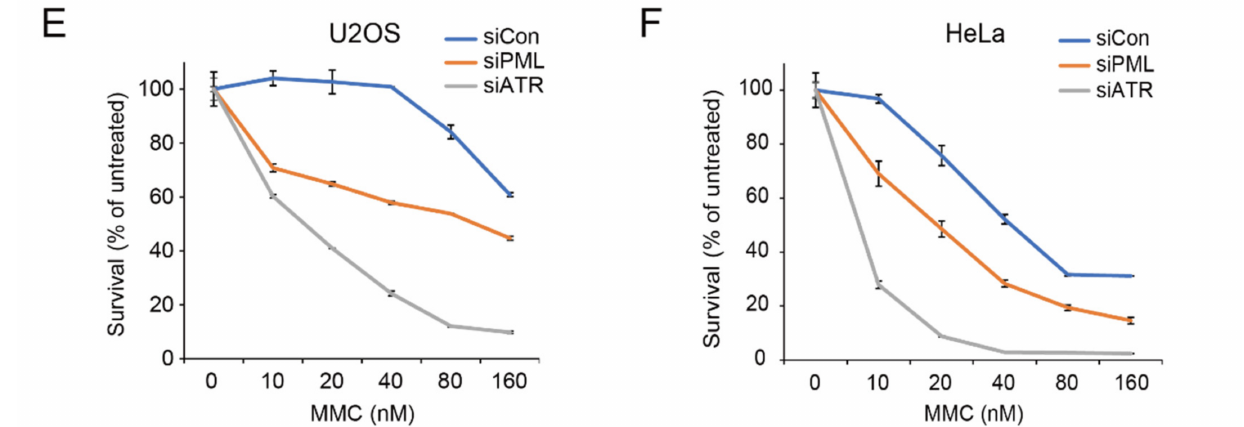
Figure 1. PML is required for FANCD2 mono-ubiquitination and foci formation in response to genotoxic agents inducing interstrand DNA crosslinks. ( A , C ) U2OS and HeLa cells were transfected with siControl, si PML , or siATR and treated with 1 µ M mitomycin C (MMC) for 24 h. FANCD2 protein expression was determined though Western blotting of cell lysates from U2OS and HeLa. Long form (L) of FANCD2 represents mono-ubiquitination and short form (S) is non-ubiquitinated FANCD2 . ( B , D ) FANCD2 foci formation in U2OS and HeLa cells treated with siControl or si PML under 1 µ M MMC exposure for one day. Representative immunofluorescence images and their quantification. Over 100 nuclei were counted for statistics. Data represent the mean ± SD from three independent experiments (*** p < 0.001). ( E , F ) Proliferation level of PML - or ATR-deficient U2OS and HeLa cells treated with indicated doses of MMC for four or five